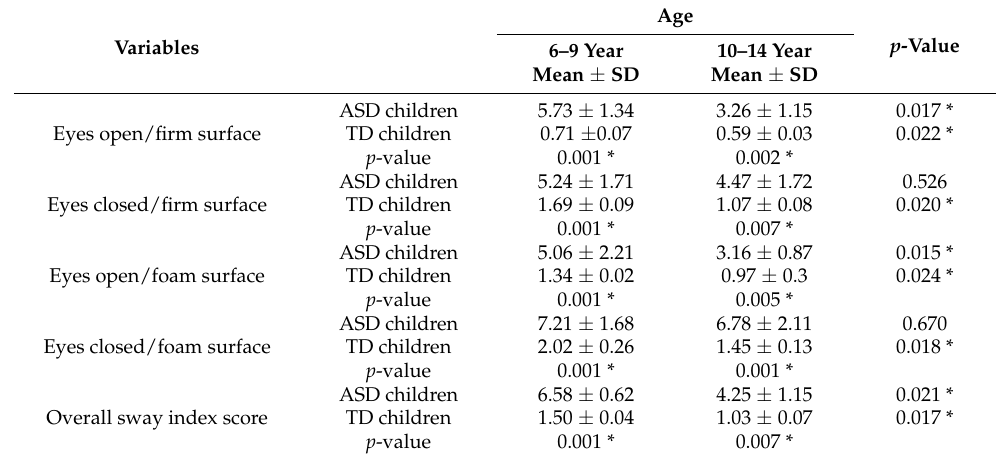
Table 2. Comparison of postural stability testing conditions of ASD and TD children based on